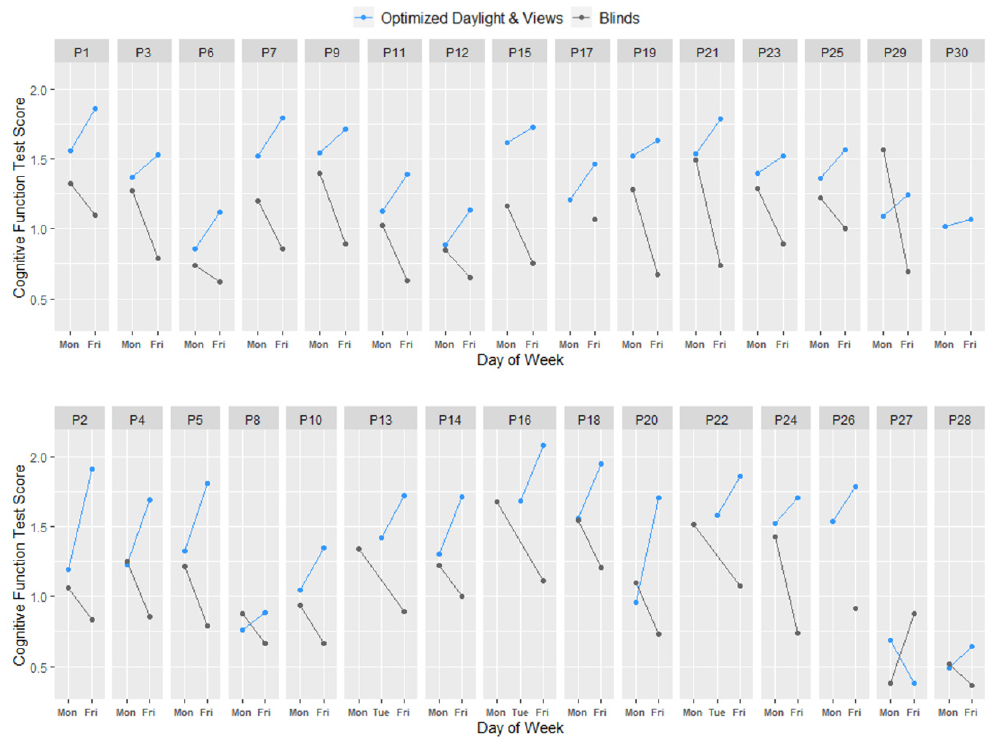
Figure 6. Average cognitive scores on the SMS assessment on each test day, normalized to the Blinds condition, for participants in Group A (top) and Group B (bottom).